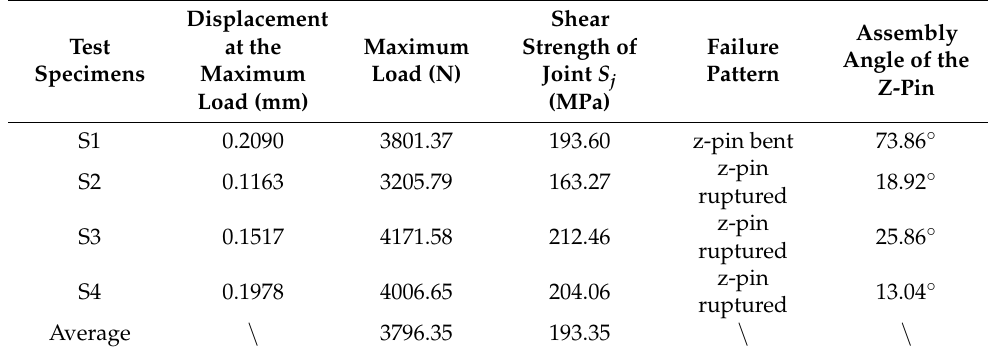
Table 1. Failure properties of the C/SiC z-pinned/bonded hybrid single-lap joint.